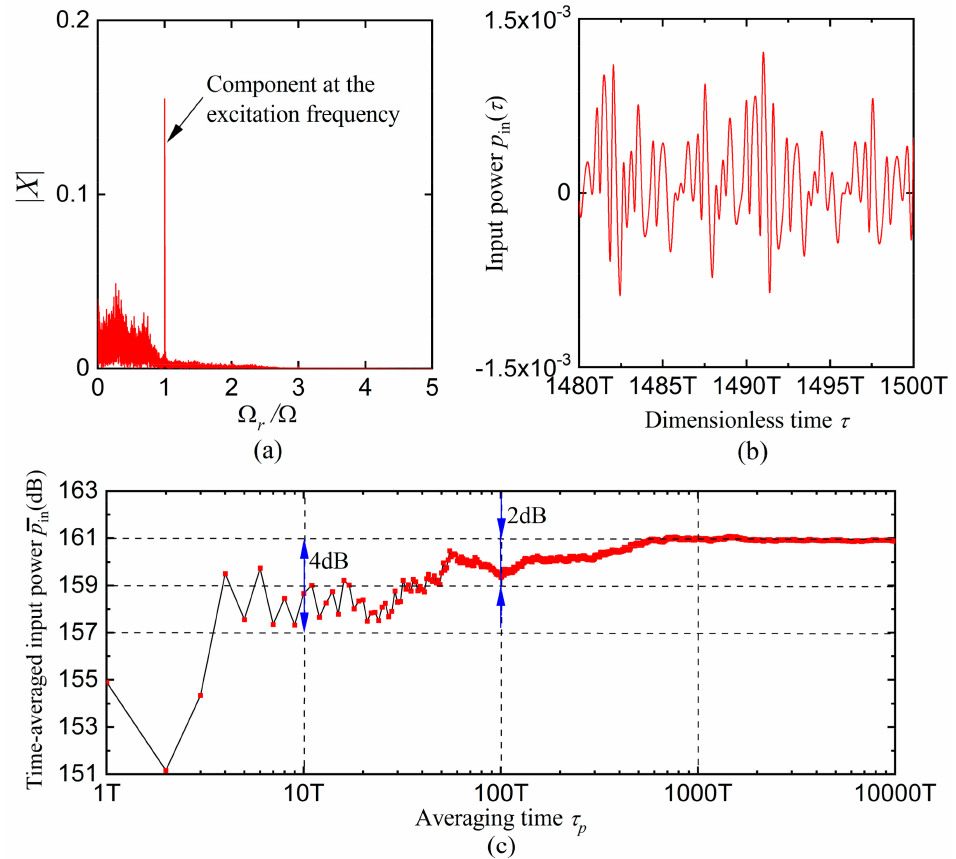
Figure 15. Dynamic response at Ω = 0.3 with α = − 0.7, β = 1.5, ξ = 0.015, F 0 = 0.01. ( a ) Frequency spectrum, ( b ) instantaneous input power, and ( c ) time–averaged input